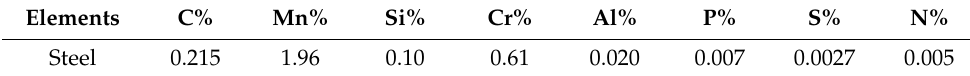
Table 1. Chemical composition of the studied bainitic steel (wt.%).